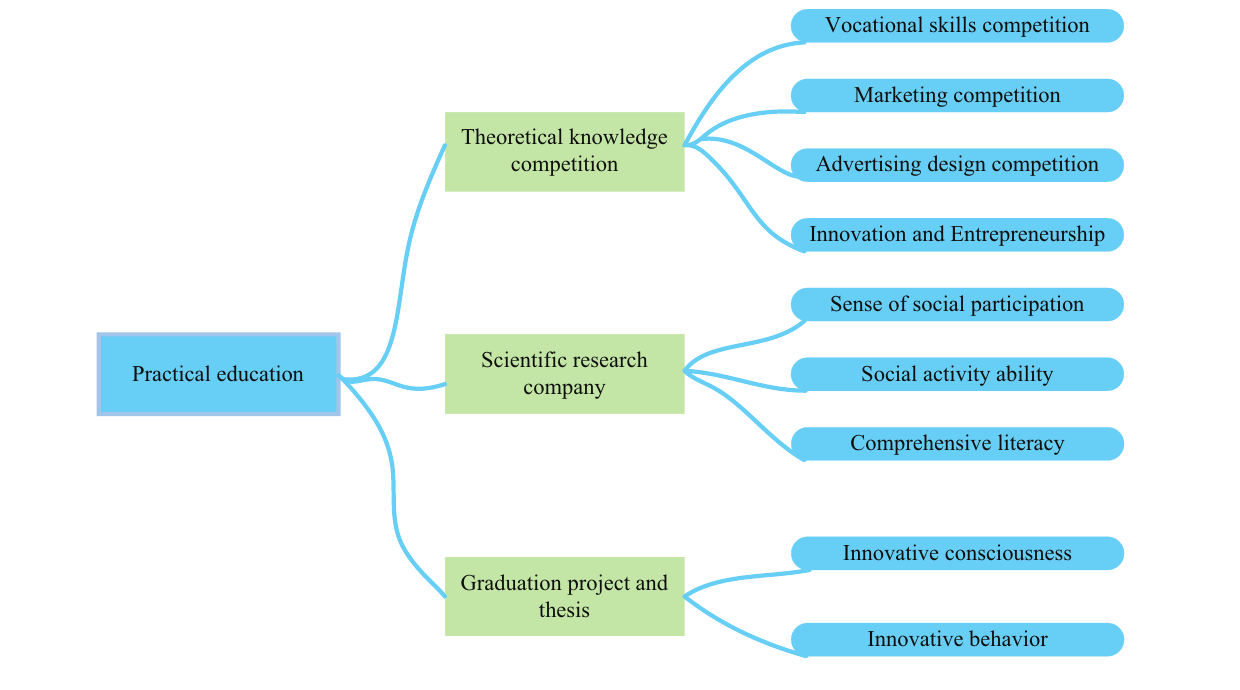
FIGURE 4 | Applied innovative talent